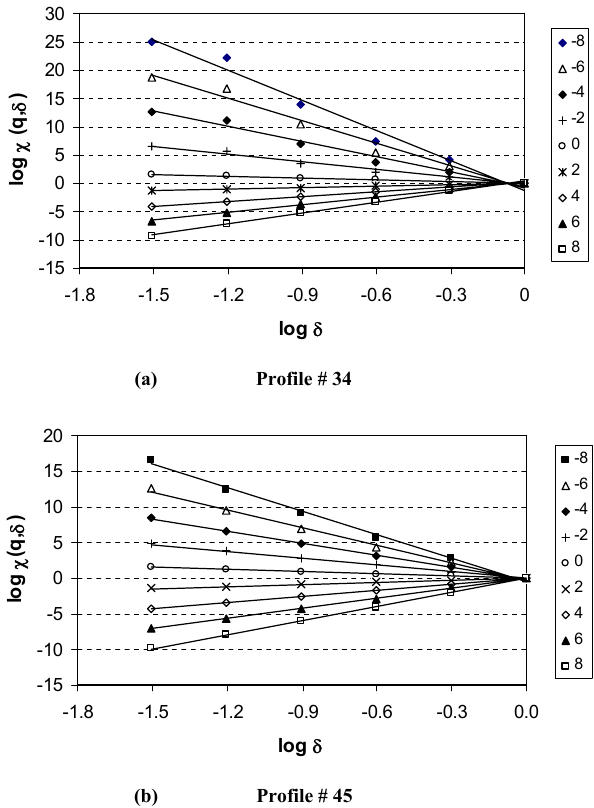
Fig. 4. Examples of log–log plots of the partition function, χ(q,δ) , versus depthdependent resolution, δ . Plots with the worst (profile #34) and the best (profile #45) linear correlations are